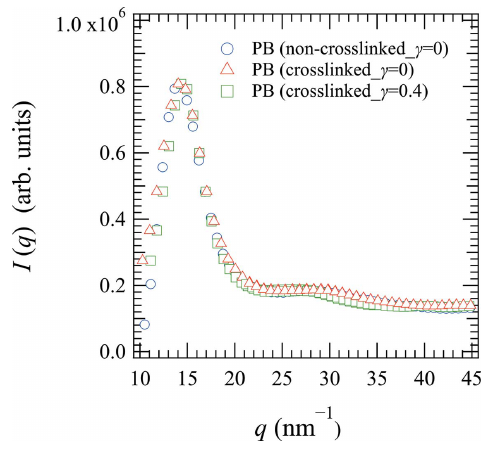
Figure 1 Scattering intensity profiles of the non-crosslinked PB at (cid:2) = 0 (blue circles) and the crosslinked PB at (cid:2) = 0 (red triangles) and 0.4 (green squares) at 303 K. The scattering intensity of the crosslinked PB at (cid:2) = 0.4 was measured in the direction perpendicular to